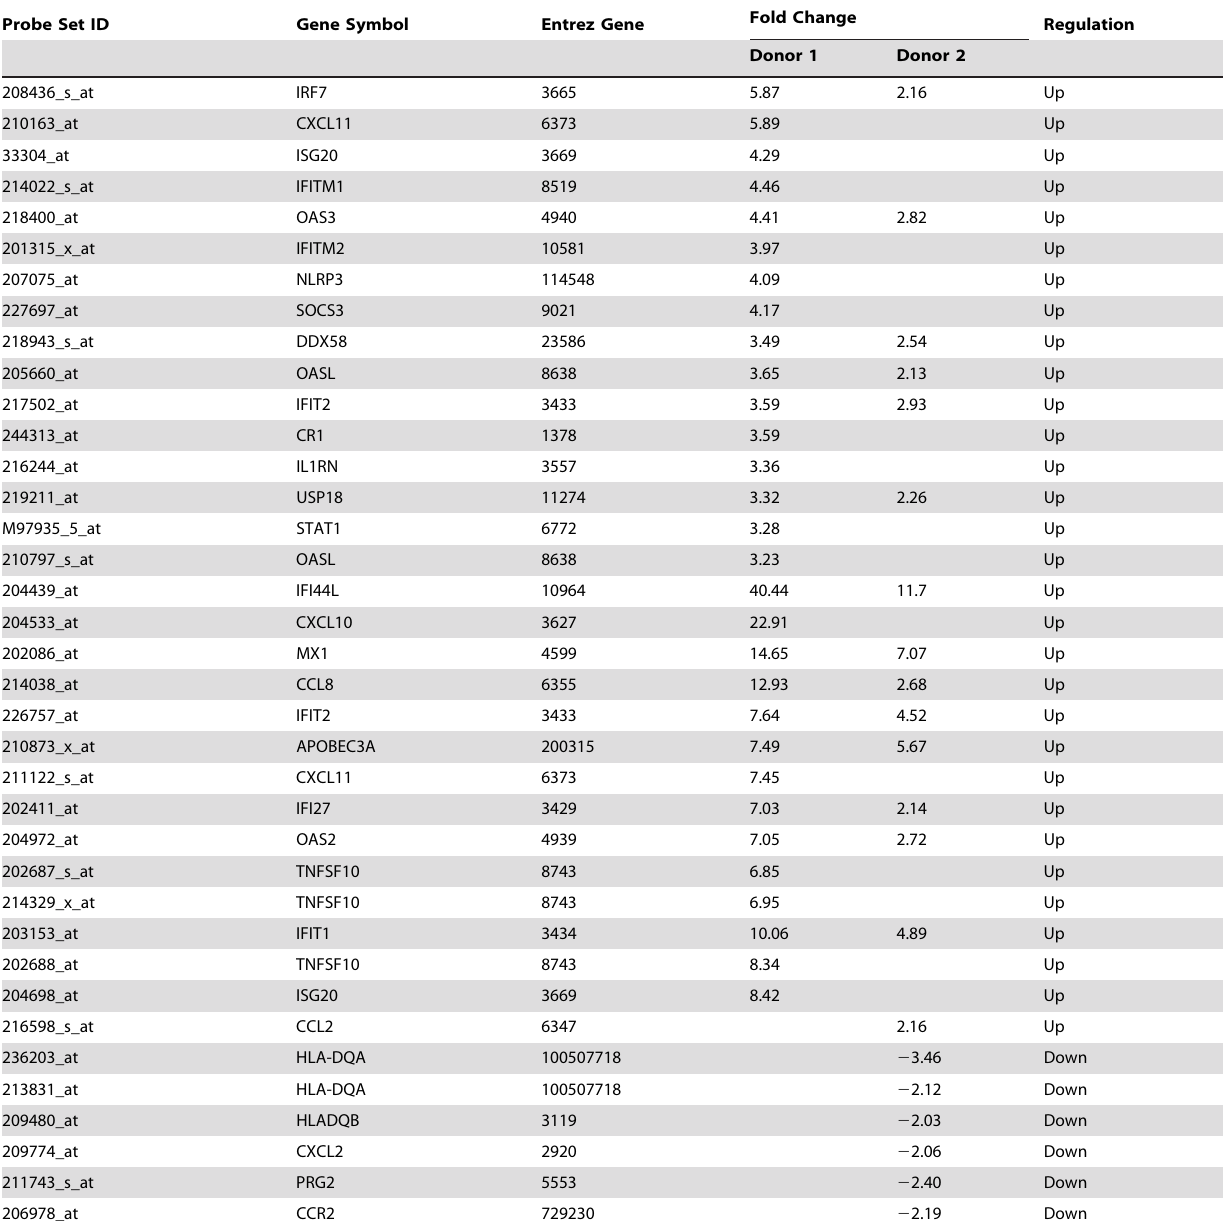
Probe Set ID Gene Symbol Entrez Gene Fold